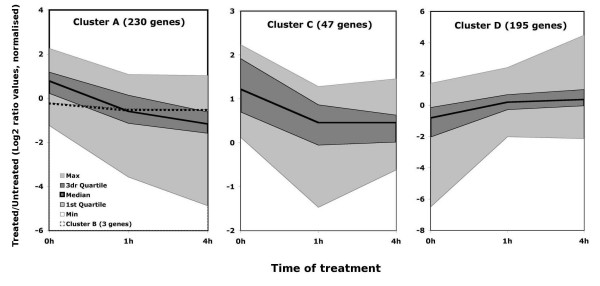
Transcriptional profiles for genes classified into clusters by SOM. Data are shown as logarithmic values of the ratio of fluorescence between treated and untreated cells before (0 h) and 1 and 4 hours after treatment. No correction was performed to compensate differences in labelling or detection of the two fluorochromes. The thick solid lines in the middle of the graphs correspond to median values, coloured areas correspond to the intervals between 1st and 3rd quartiles (dark gray) and the total distribution (light gray). Averaged values for Cluster B (3 genes, discontinuous line) in included in the Cluster A plot.